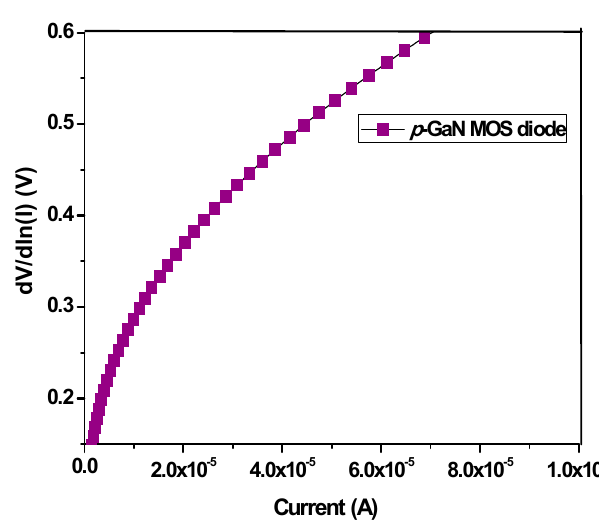
Figure 4. Plot of d V /dln( I ) versus I for the as-deposited Al/SiO 2 / p- GaN MOS Schottky diode.